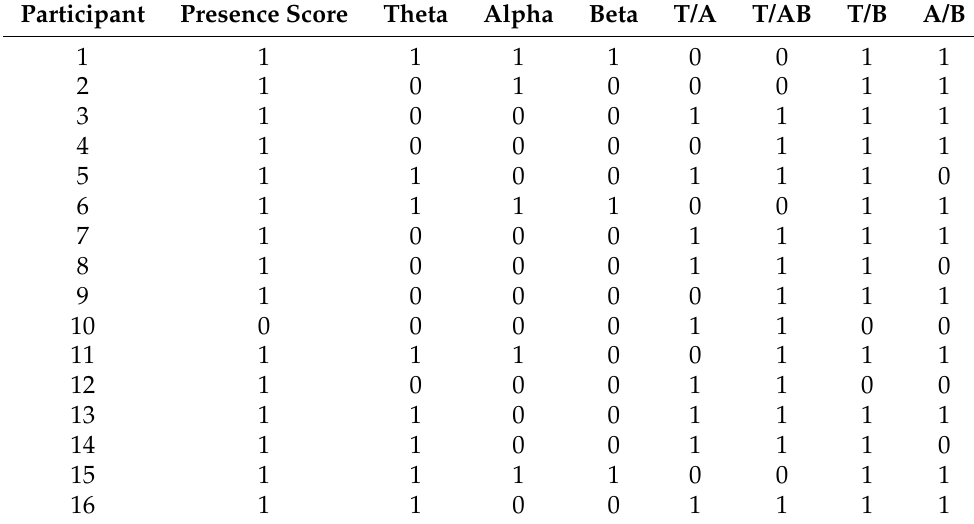
Table 3. Data displayed in the dichotomous